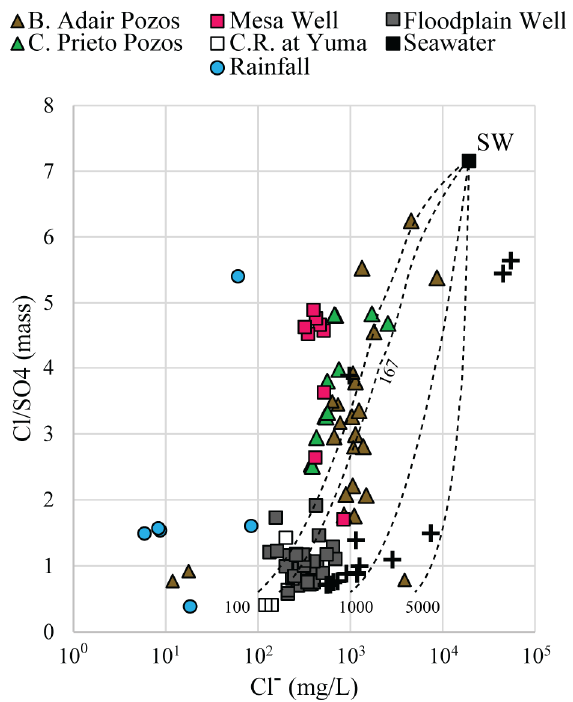
Figure 11. Cl − / SO 42 − (mass) vs. Cl − concentration (mg / L, log scale) for surface and groundwaters in this study. Dashed lines show hypothetical mixing lines between seawater (SW)—or whole salt as aerosols—and Colorado River water.